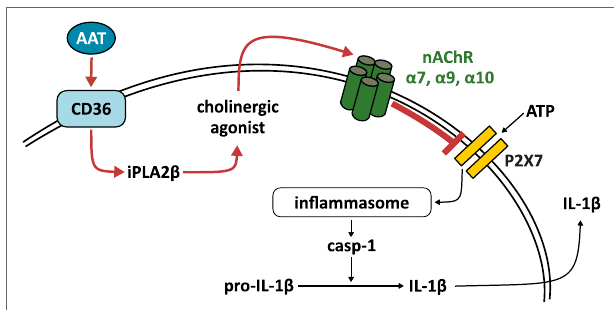
FigUre 7 | Suggested signaling mechanism of the alpha-1 antitrypsin (AAT)-induced control of ATP-induced inflammasome activation. Our results are in line with the following hypotheses: AAT binds to CD36 and induces activation of calcium-independent phospholipase A2 β (iPLA2 β ), which cleaves membrane lipids and forms a yet unknown low molecular weight factor, presumably a cholinergic agonist. This agonist is released, activates nicotinic acetylcholine receptors (nAChR) containing subunits α 9, α 10, and/or α 7 and inhibits the signaling of the ATP-sensitive P2X7 receptor. Our data suggest that AAT prevents inflammasome assembly, activation of caspase-1 (casp-1), and release of interleukin (IL)-1 β . Red arrows symbolize mechanisms that were investigated in this